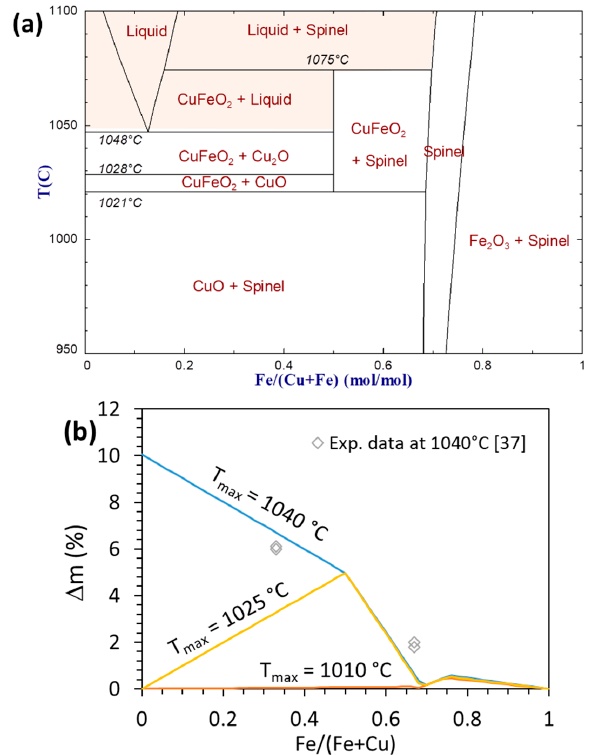
Figure 11. ( a ) Calculated phase diagram (model from [52]) of the Cu-Fe-O system in air, with highlight on the presence of the liquid phase ( b ) Evolution of mass change with composition for cycles between T min = 800 ◦ C and T max = 1010, 1025 and 1040 ◦